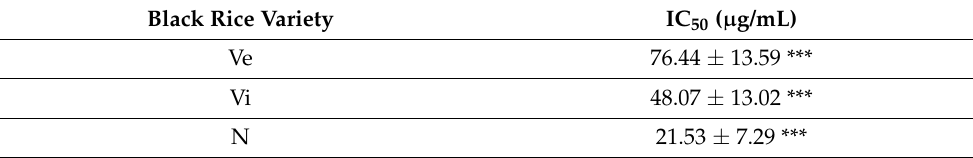
Table 3. IC 50 s of extracts from black rice varieties (Ve, Vi, Ne) on CXCL-10 release.